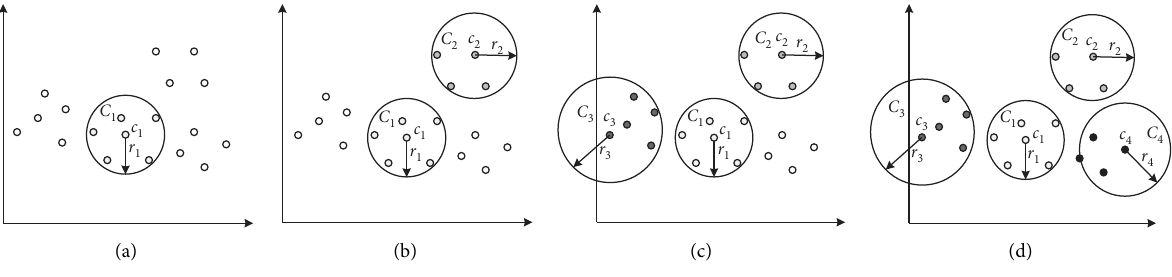
Figure 4: A clustering example. (a) Iteration #1. (b) Iteration #2. (c) Iteration #3. (d) Iteration #4.